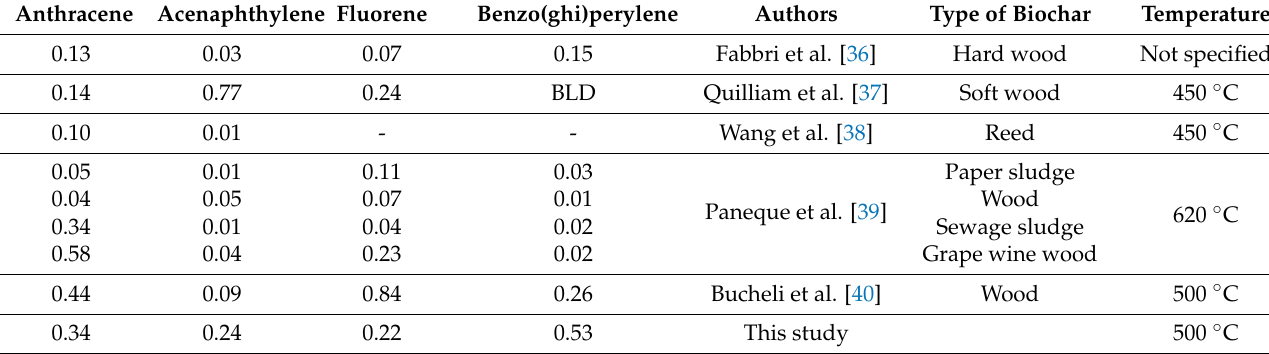
Table 7. Comparison of the value of selected PAHs in several biochars